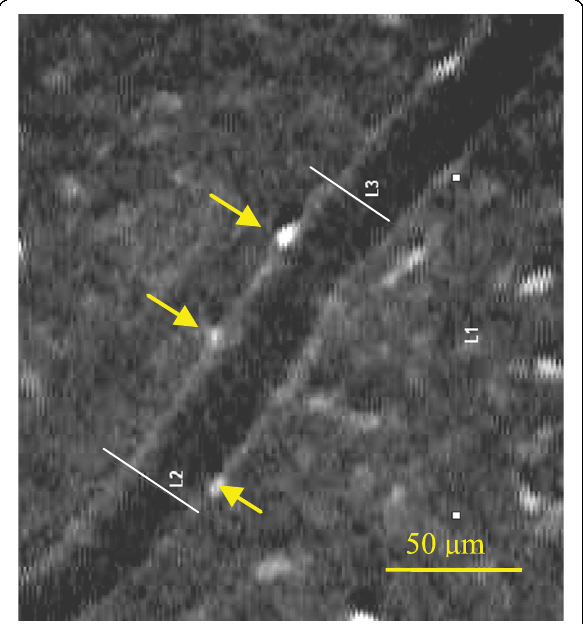
Figure 1 Ethidium bromide-positive nuclei . Number of ethidium bromide (EB)-positive nuclei from the selected arteriolar wall. The white lines depict the 100-micron vascular length where EB-positive nuclei were counted. (Bar represents 50 μ m).